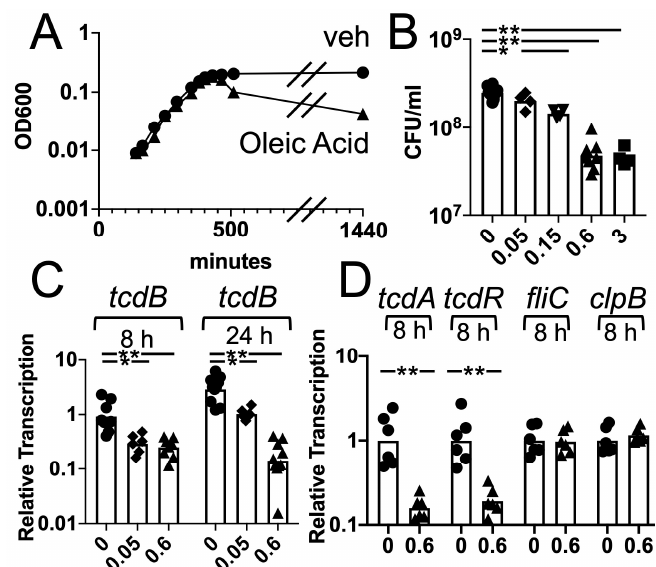
Figure 6. Altered survival and gene transcription in the C. di ffi cile cells grown in the presence of oleic acid. C. di ffi cile cells of the strain UK1 were grown overnight in a pre-reduced TY (3% bacto tryptose, 2% yeast extract, 0.1% thioglycolate, pH 7.4) broth. The cultures were back diluted to OD 600 = 0.02 and grown in pre-reduced TY broth supplemented with ethanol or with oleic acid in ethanol. Final concentrations of oleic acid varied as shown in the figure (0, 0.05, 0.15, 0.6 and 3 mM). ( A ) Growth in the presence of 0.6 mM oleic acid or the ethanol vehicle was monitored by taking samples at various times and reading OD 600 . One experiment representative of 3 independent experimental trials is shown. ( B ) Survival after 25 h of culture with the indicated concentration of oleic acid was measured by plating. Each symbol indicates the results from an independent culture and the bar is the geometric mean. (one-way ANOVA with post hoc Dunnett’s multiple comparisons test *, p = 0.003; **, p < 0.0001). ( C ) C. di ffi cile cells grown for 8 or 24 h with the indicated concentration of oleic acid were harvested in RNAprotect. RNA was extracted and the gene transcription was measured in cDNA and normalized to rpoA transcription. Each symbol indicates results from an independent culture and the bar is the geometric mean. (one-way ANOVA with post hoc Dunnett’s multiple comparisons test *, p < 0.02; **, p < 0.0003). ( D ) Samples were treated as in (C). Each symbol indicates the results from an independent culture and the bar is the geometric mean. ( t test, **, p < 0.0003).